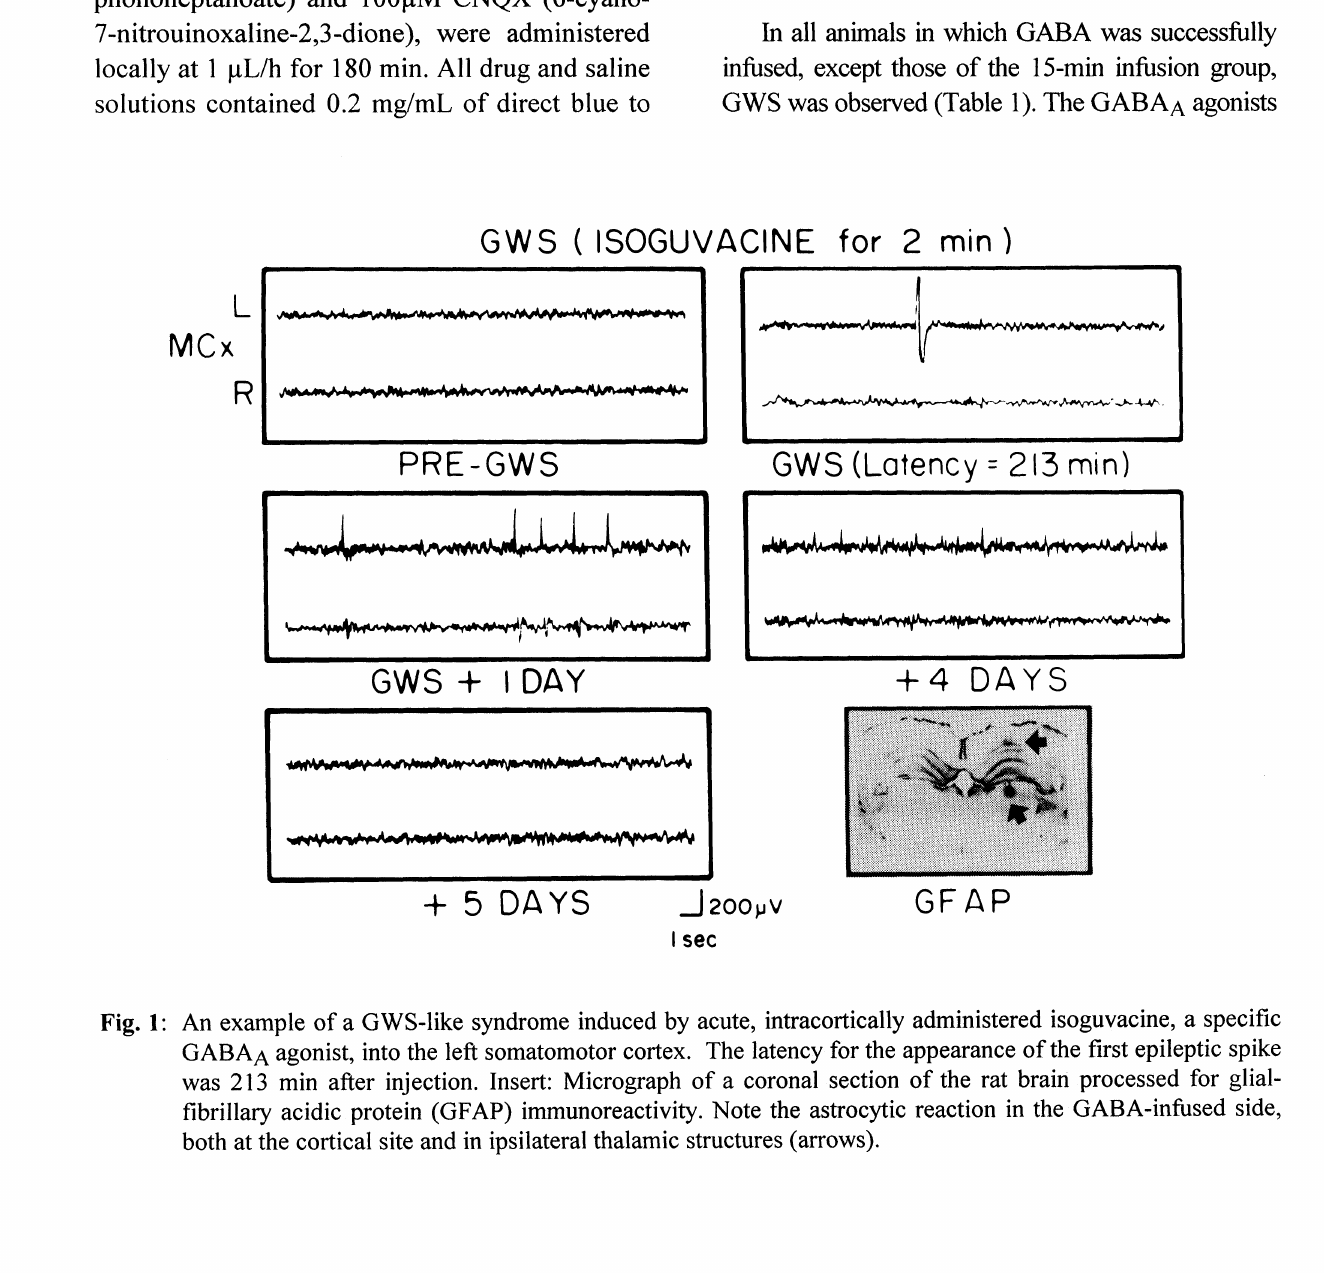
Fig. 1: An example of a GWS-like syndrome induced by acute, intracortically administered isoguvacine, a specific GABAA agonist, into the left somatomotor cortex. The latency for the appearance of the first epileptic spike was 213 min after injection. Insert: Micrograph of a coronal section of the rat brain processed for glial- fibrillar acidic protein (GFAP) immunoreactivity. Note the astrocytic reaction in the GABA-infused side, both at the cortical site and in ipsilateral thalamic structures